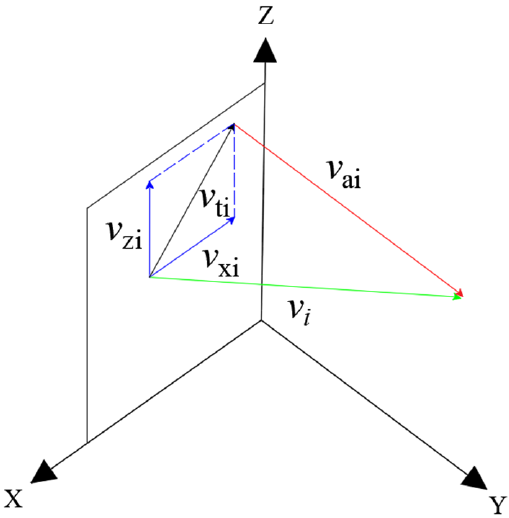
Figure 6. Velocity triangle on overflowing section.